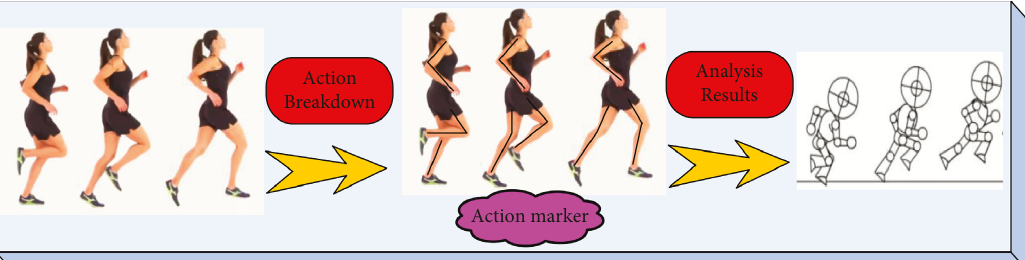
Figure 1: Schematic figure of sprinting cluster analysis.